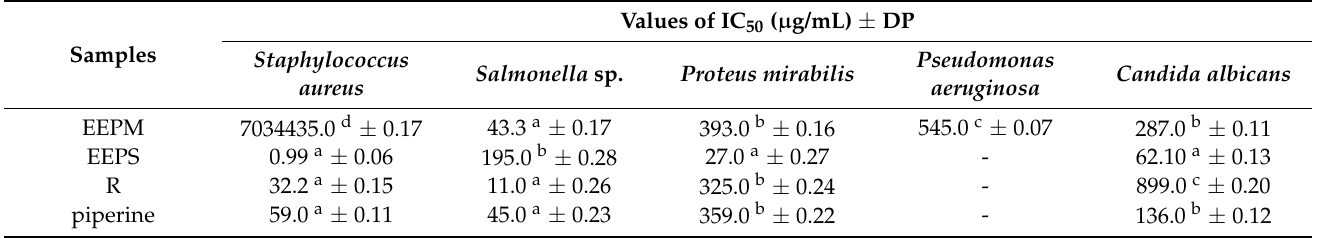
Table 1. Evaluation of antimicrobial and antifungal activities of EEPM, EEPS, RP, and piperine samples of black pepper from the IC 50 inhibition coefficient for the microorganisms